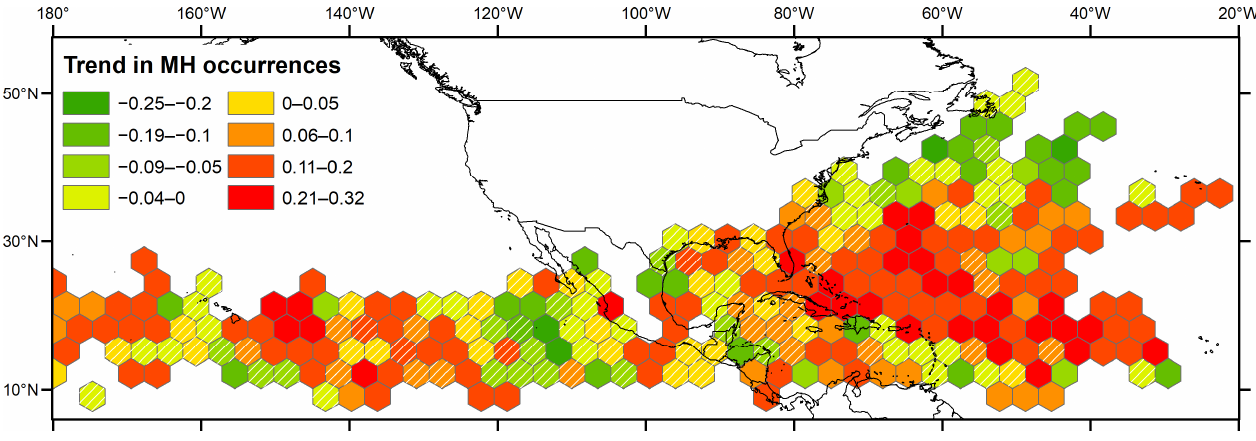
Figure 5. Trends in MH occurrences from 1970 to 2021. Cells hatched with white lines have a non- significant trend ( p >